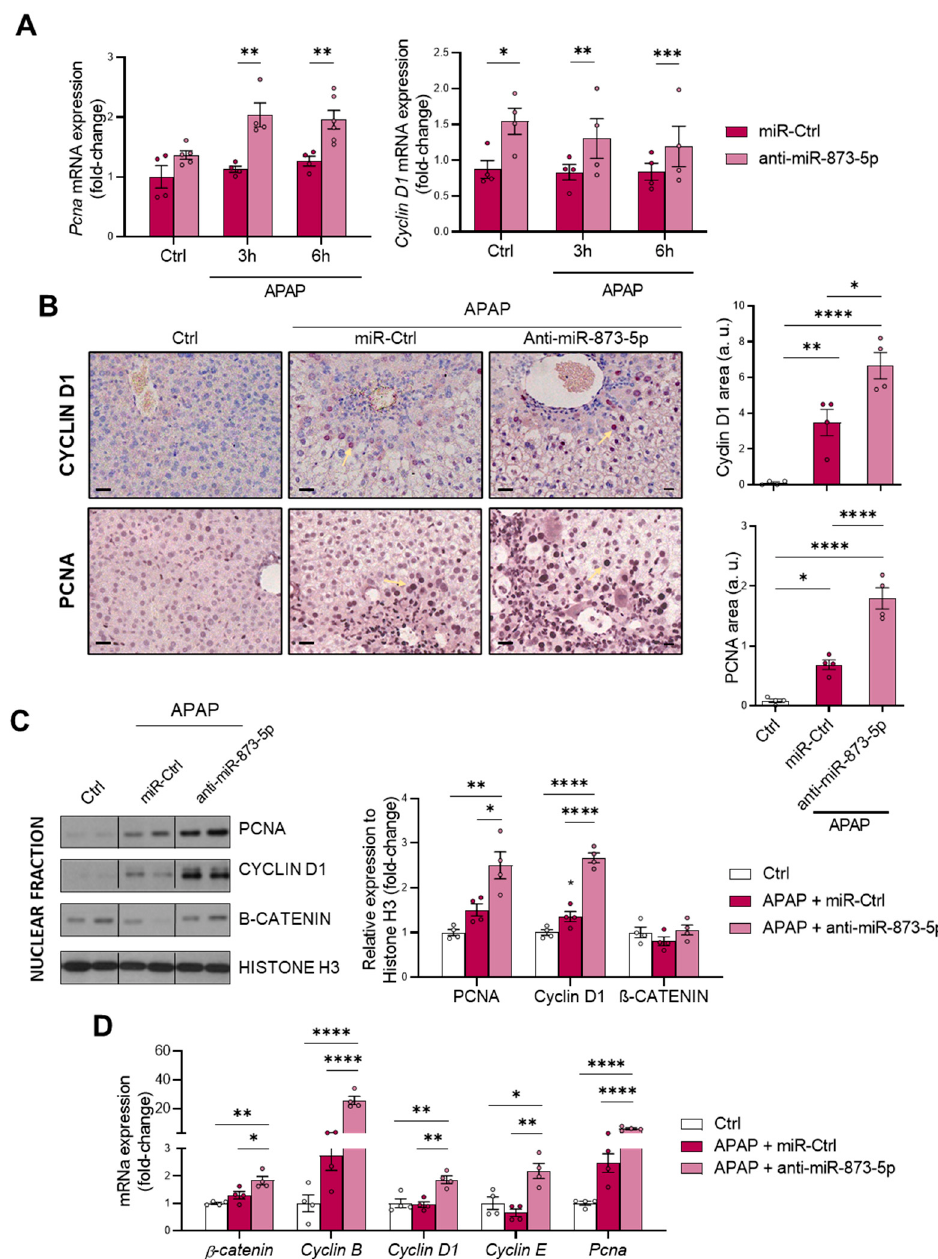
Figure 7. anti-miR-873-5p therapy promotes hepatocyte proliferation for liver regeneration against APAP. ( A ) Relative mRNA expression of proliferating cell nuclear antigen ( Pcna) and cyclin D1 in primary hepatocytes treated with 10mM acetaminophen (APAP) for 3 and 6 h and either an anti-miR-873-5p or a miR-Ctrl; ( B ) representative micrographs of hepatic cyclin D1 and PCNA stainings (highlighted with yellow arrows) and respective determination; ( C ) Western blot of nuclear fractions of PCNA, cyclin D1 and β -catenin and respective quantification using Histone H3 as a loading control; ( D ) relative hepatic mRNA expression of proliferation genes in mice treated with 360 mg/kg APAP for 48 h and either anti-miR-873-5p or miR-Ctrl. Scale bar corresponds to 50 μ m. * p < 0.05, ** p < 0.01, *** p < 0.001, **** p < 0.0001 are shown.